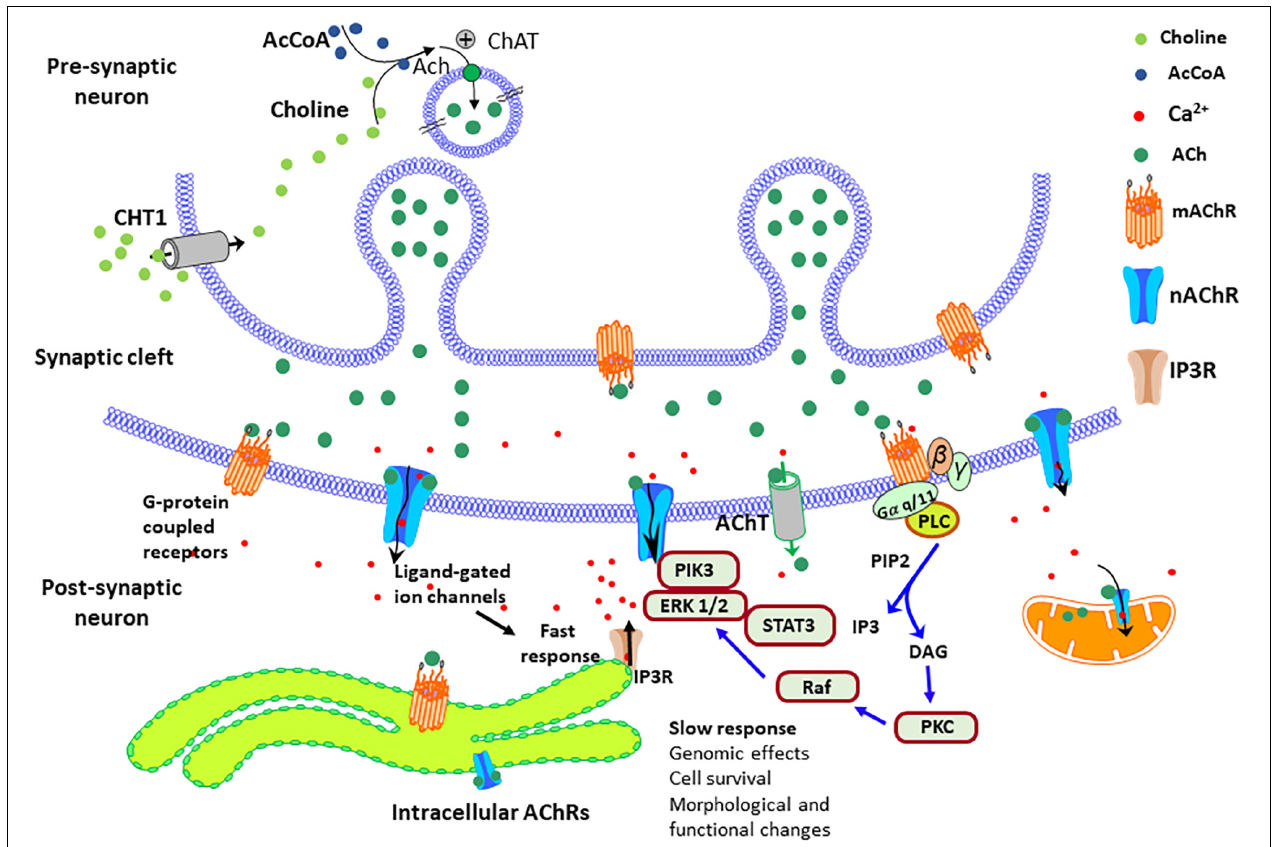
FIGURE 4 | Simplified diagram of the AChRs signal transduction pathways in the pre-and post-synaptic sites. In brain cells, intracellular AChRs – both mAChRs and nAChRs are located on both the surface of the plasma membrane and intracellular membranes of various organelles, such as endosomes, Golgi apparatus, endoplasmic reticulum, mitochondria, and nuclear membranes. The choline transporter-like protein1 (CHT1) uptake choline at the presynaptic, and the acetylcholine (ACh) transporter (AChT) uptake ACh at the post-synaptic site. The entrance of calcium throughout the nAChRs stimulates signaling factors, such as the enzymes phosphatidylinositol 3-kinase (PI3K)/ extracellular signal-regulated protein kinase (ERK)1/2/ signal transducer and activator of transcription 3 (STAT3). These factors prevent apoptosis and stimulate the expression of prosurvival genes, The signaling cascades elicited by the mAChRs stimulate the release of calcium from intracellular stores via the activation of PLC that generates the Inositol trisphosphate (IP3) that activates the IP3 receptors (IP3Rs) and the second messenger diacylglycerol (DAG) that stimulates the protein kinase C (PKC)/ Raf/ ERK